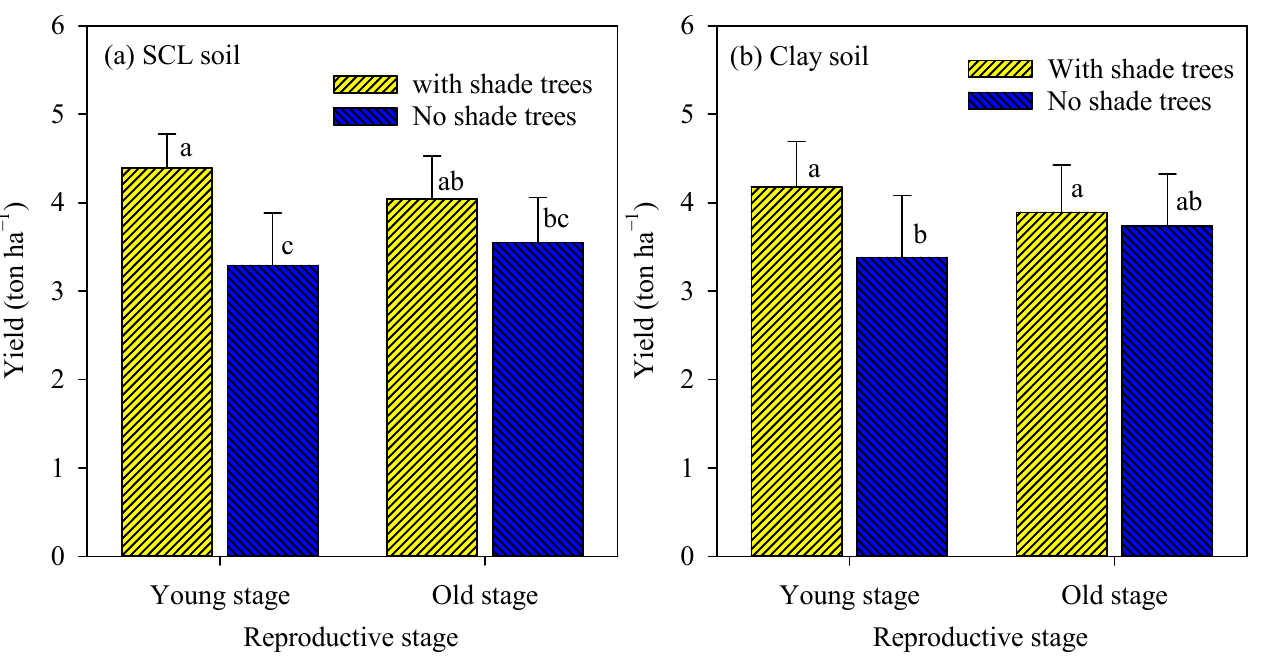
Figure 2. Coffee yield in the two reproductive stages in SCL soil ( a ) and clay soil ( b ) as affected by shade trees. For each panel, columns attached with the same letter were not significantly different from the others at p ≤ 0.05. The error bars indicated standard deviation. SCL = sandy clay loam.